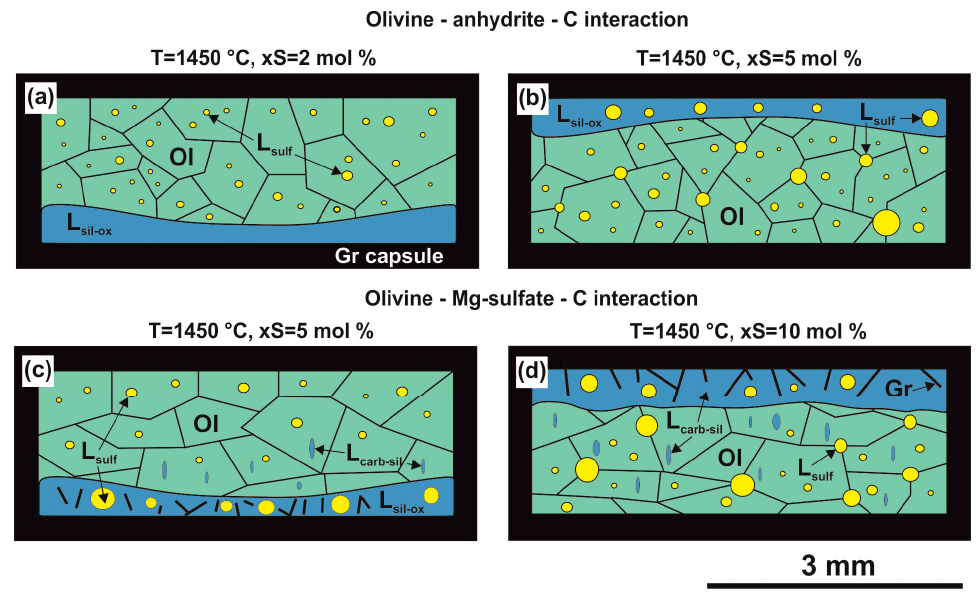
Figure 6. Schematic images of experimental results at 1450 °C in olivine-anhydrite-C system at xS = 2 mol % ( a ) and xS = 5 mol % ( b ) and in Mg-sulfate–olivine system at xS = 5 mol % ( c ) and xS = 10 mol % ( d ); Ol —olivine, Gr —graphite, L sulf —sulfide melt, L sil-ox —silicate-oxide melt. Table 4. Compositions of sulfides.